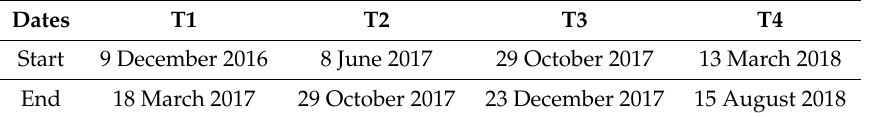
Figure 4. Time variation of beach area, A b , from 1 December 2016 to 7 October 2018. T1, T2, T3, and T4, marked by the blue vertical lines, denote the time periods selected for the analysis during which A b shows a specific variation pattern. Table 1. Start and end dates of the four selected periods.